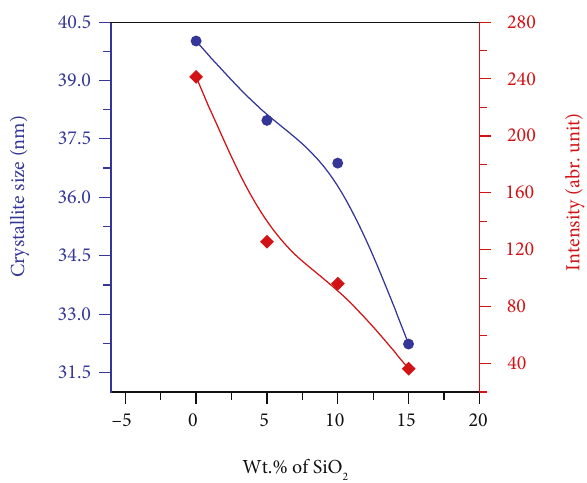
Figure 3: Variation of CS and peak intensity of ZnO (101) plane as a function of increasing of wt.% of silica